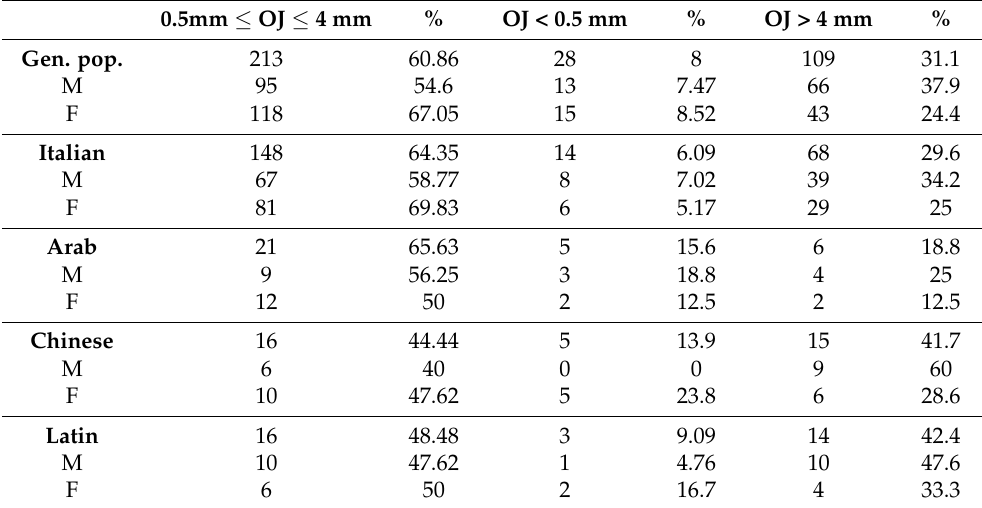
Table 9. Distribution of overjet values in the selected patient